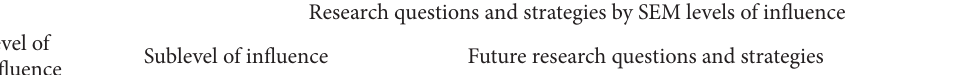
Table 1: Research questions and strategies by social ecological model levels of influence